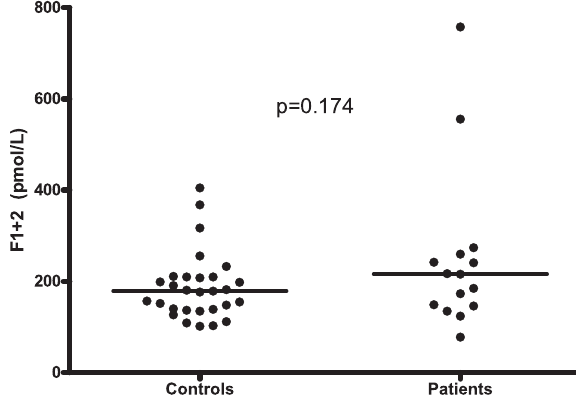
Figure 5. Plasma levels of prothrombin fragment 1+2 in patients and healthy controls. Horizontal bars indicate